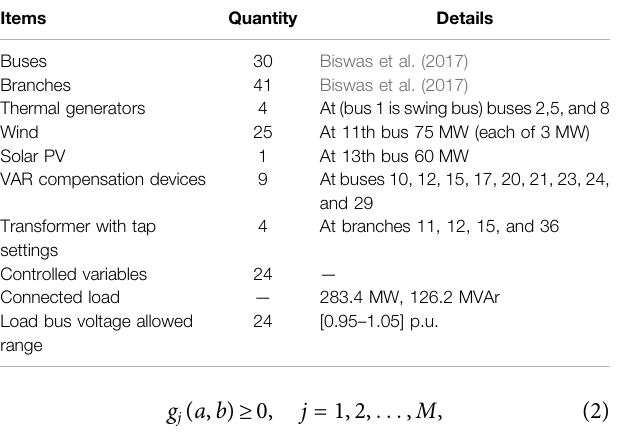
TABLE 2 | System model summary.